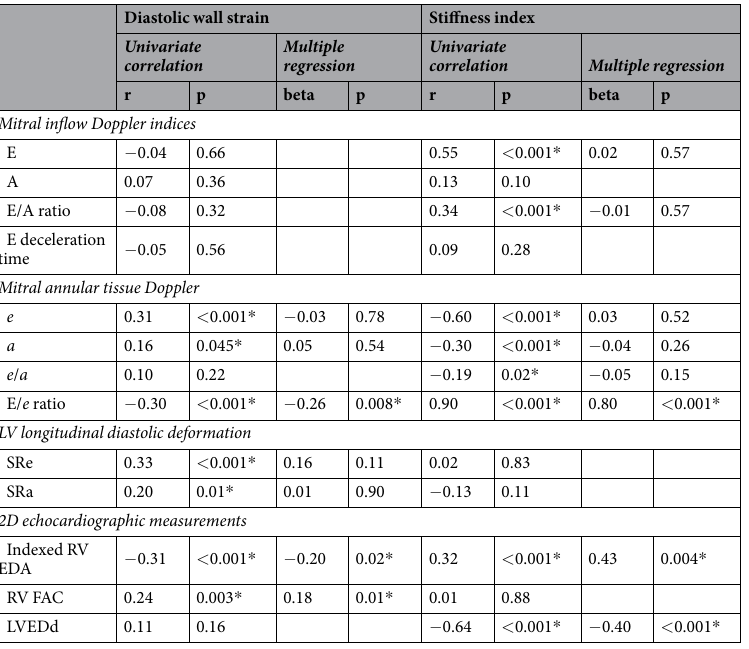
Table 2. Correlation between left ventricular stiffness and indices of left and right ventricular function. Abbreviation as in Table 1. * Statistically